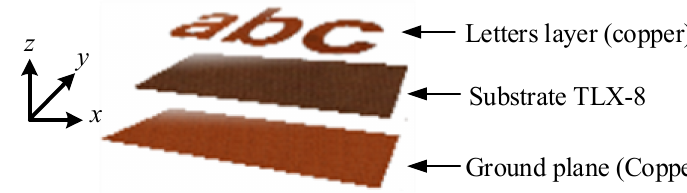
Figure 3. 3D exploded real view of the letter tags showing the two metalized faces from each side of a common planar TLX-8 substrate of size of 4 cm × 2 cm.